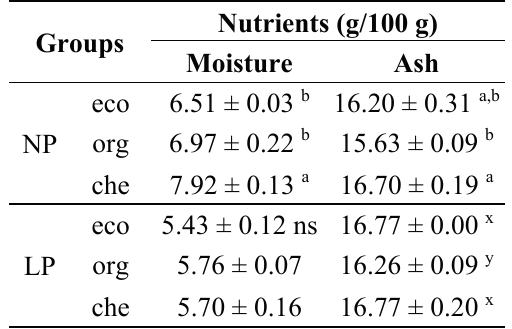
Table 1. Moisture and ash composition of chicory.